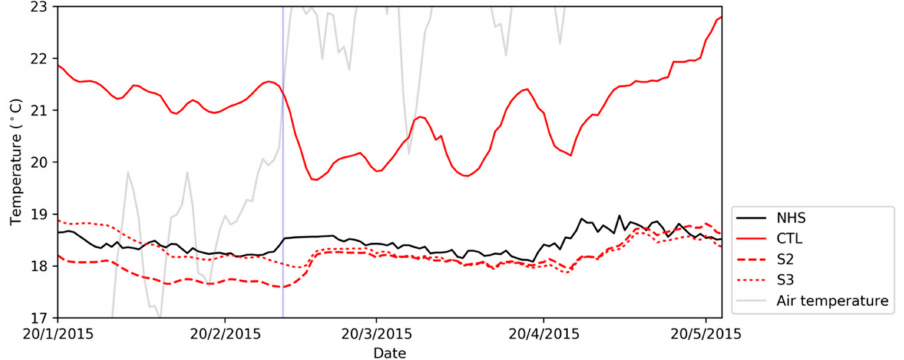
Figure 10. Simulated water temperature by CTL, S2, and S3 at the YHS. The measured water temperature at the NHS and air temperature at the Nuozhadu Dam are shown for reference. The vertical blue line indicates the boundary of the period when air temperature was significantly lower than water temperature at the YHS.